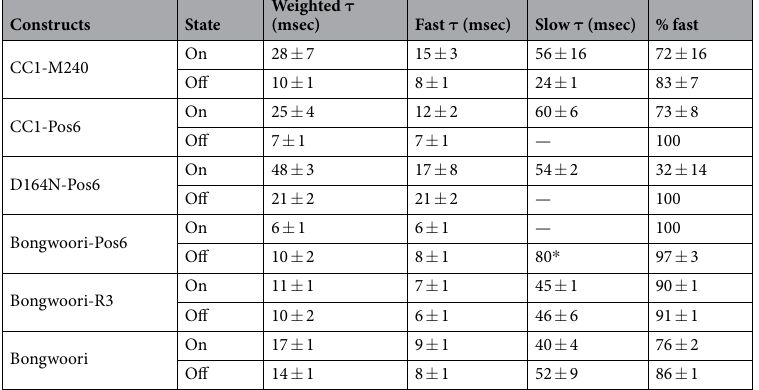
contrast of the spiking activity (Fig. 5C). Even though Bongwoori-R3 is not as fast as ASAP-1 (taus around 2 msec) 26 , its larger signal size (and decent speed) enable Bongwoori-R3 to better resolve action potentials firing at a frequency as high as 65 Hz (Fig. 5D). Indeed, the CC1-Pos6 and the D164N-Pos6 constructs do not resolve spiking activity in neurons as well as Bongwoori-R3 (Supplementary Figure 2). Baseline drift of the fluorescence for Bongwoori when expressed in neurons is due to the acidi- fication of the cell firing action potentials. One drawback in the original publication of Bongwoori was that for neuronal recordings the baseline fluorescence tended to drift. Although the baseline drift did not hinder the resolution of action potentials firing at 60 Hz, we were curious as to why the drift was seen only in neuronal recordings and not when Bongwoori was expressed in HEK cells 4 . signal for another GEVI, Pado, that uses the same FP fused to a VSD from a voltage-gated proton channel 15 . Since